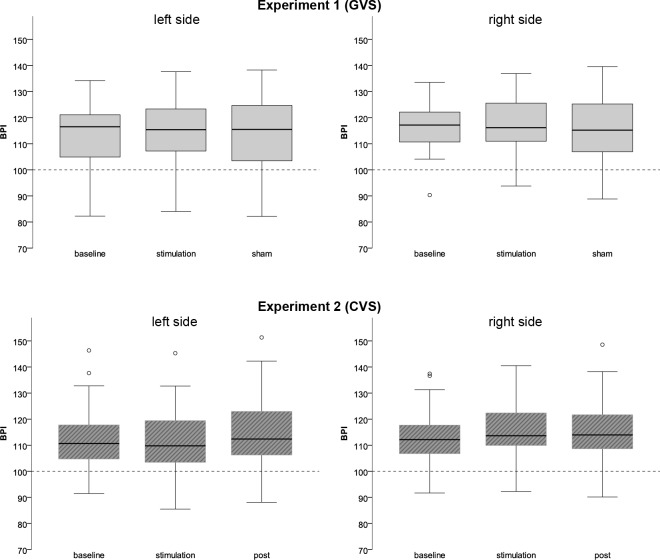
Body perception results.Boxplots of aggregated body perception indices (BPI; estimated/actual length * 100) for the left and right body side at baseline, under vestibular stimulation and at sham/post-assessment. BPI > 100 indicates overestimation, BPI < 100 indicates underestimation. There was no significant change in BPI due to vestibular stimulation in any of the experiments. Experiment 1 (left anodal subthreshold galvanic vestibular stimulation; GVS) is depicted in the top row; experiment 2 (left caloric vestibular stimulation with cold water; CVS) is depicted in the bottom row.